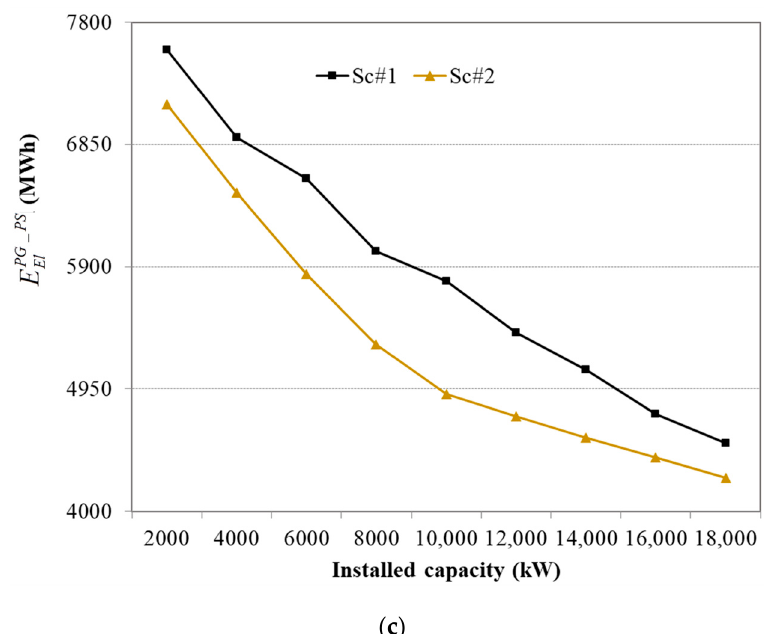
Figure 4. Trends of the electrical energy ( a ) distributed within the local grid; ( b ) exported to the main power grid; ( c ) requested to the main power grid.